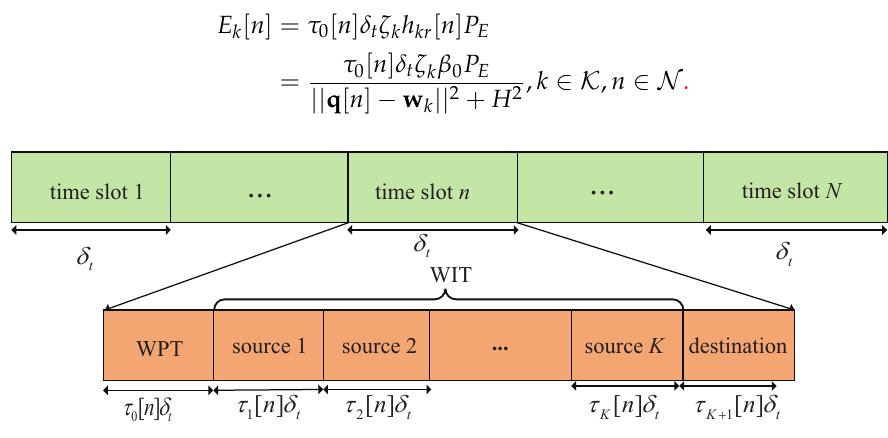
Figure 2. Communication protocol for the